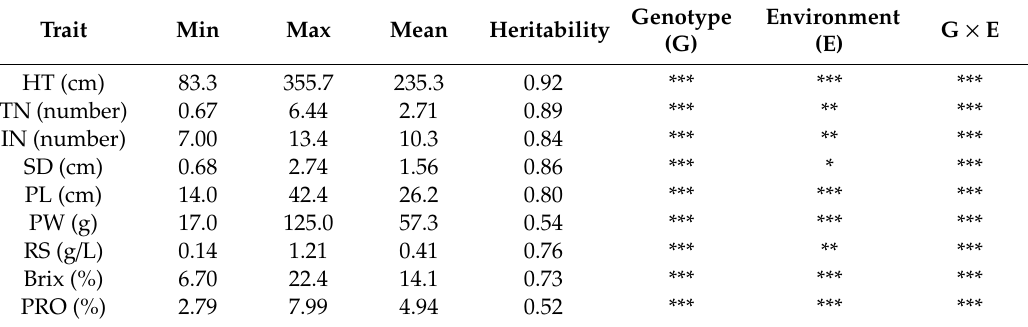
Genotype Environment G × E (G) (E)